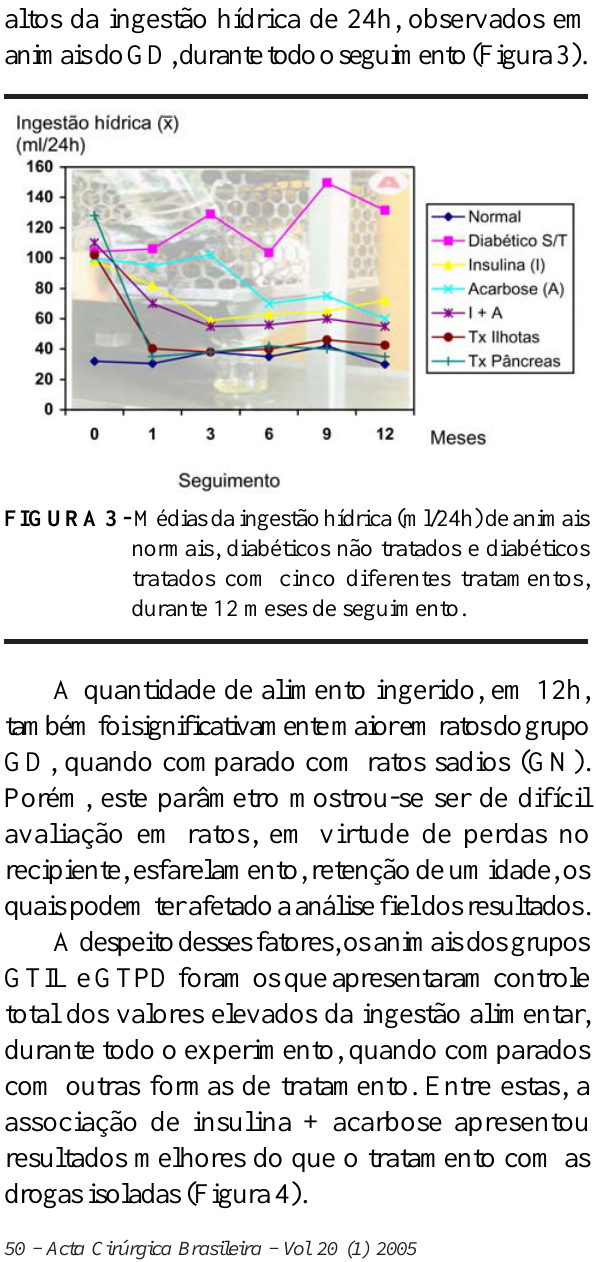
FIGURA 4 - Medianas da ingestão alimentar (g/12h) de animais normais, diabéticos não tratados e diabéticos tratados com cinco diferentes tratamentos, durante 12 meses de